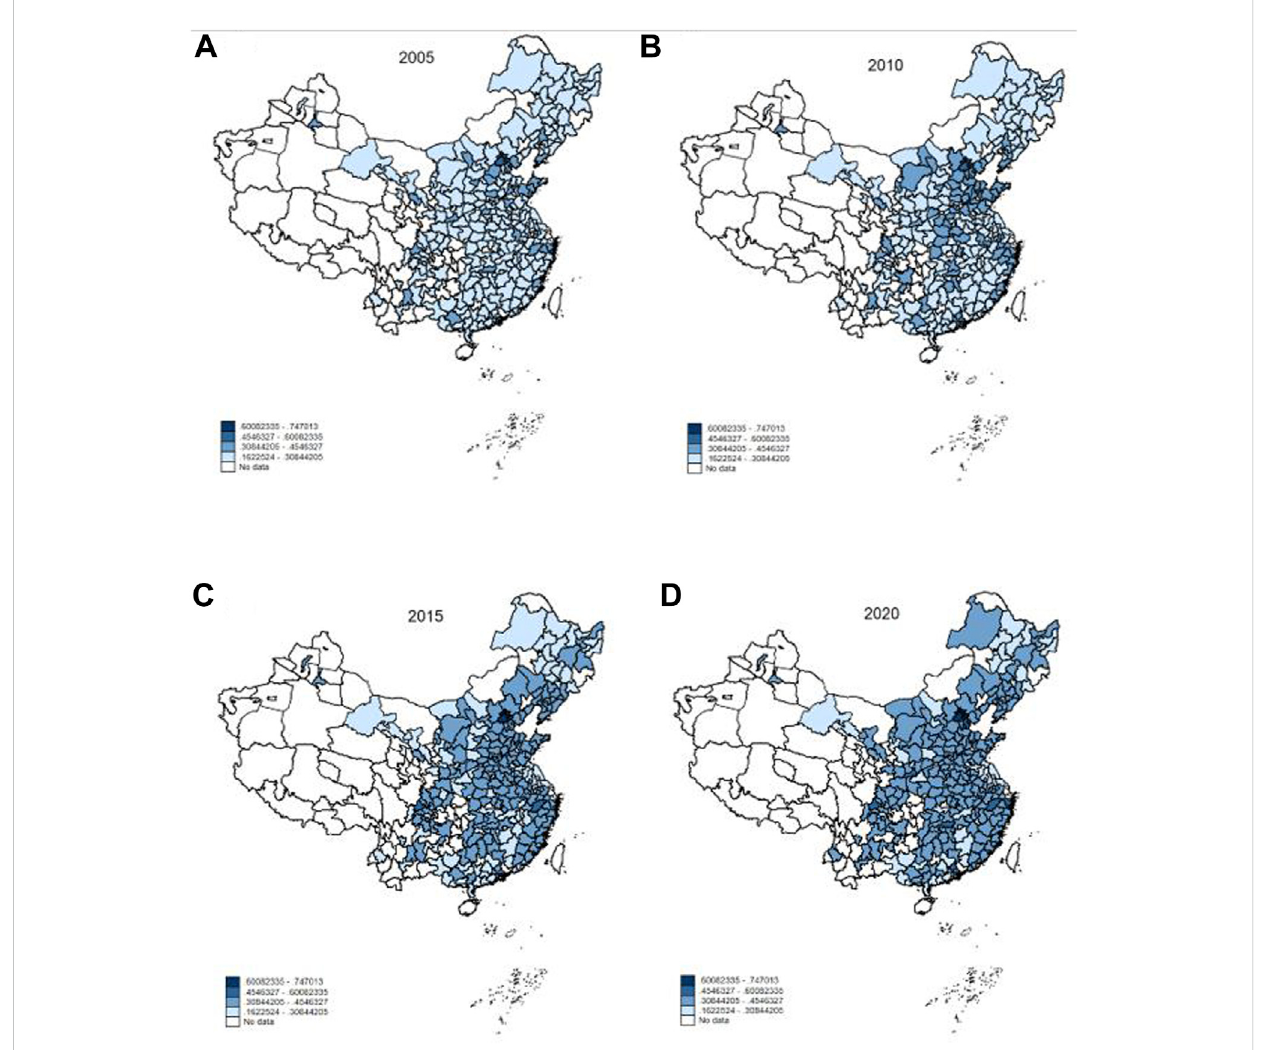
FIGURE 3 The spatial pattern evolution of the coupling coordination degree between the scienti fi c and technological fi nance system and the green development system. (A) The coupling and coordination of science and technology fi nance and green development in 2005; (B) The coupling and coordination of science and technology fi nance and green development in 2010; (C) The coupling and coordination of science and technology fi nance and green development in 2015; (D) The coupling and coordination of science and technology fi nance and green development in